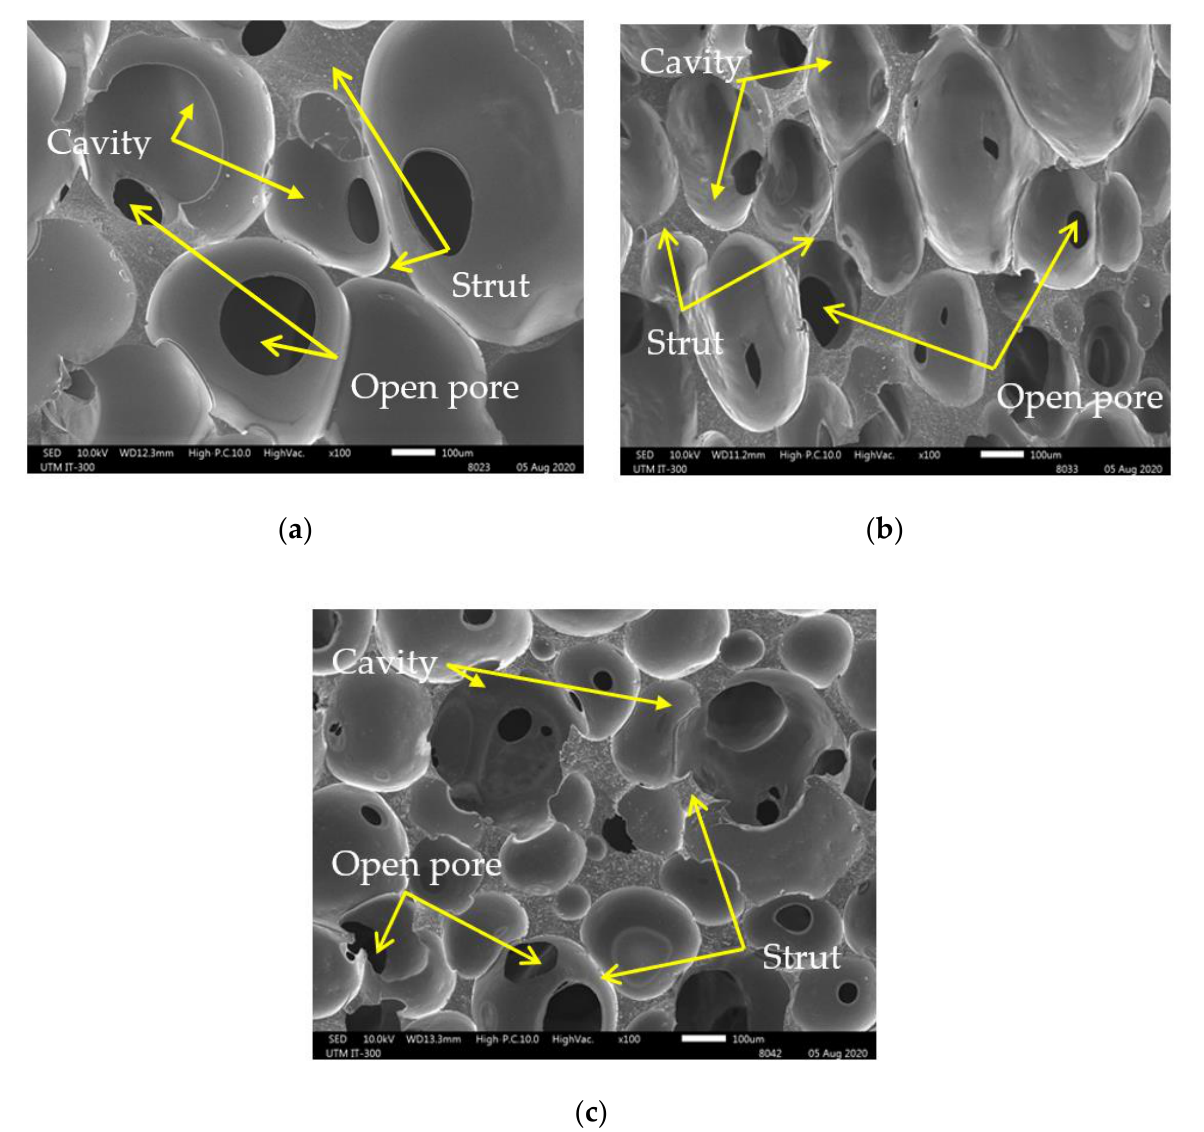
Figure 9. SEM images with magnification 100x of ( a ) polyurethane (PU) foam, ( b ) 55 wt.% and ( c ) 75 wt.% of CIPs within MA foams.